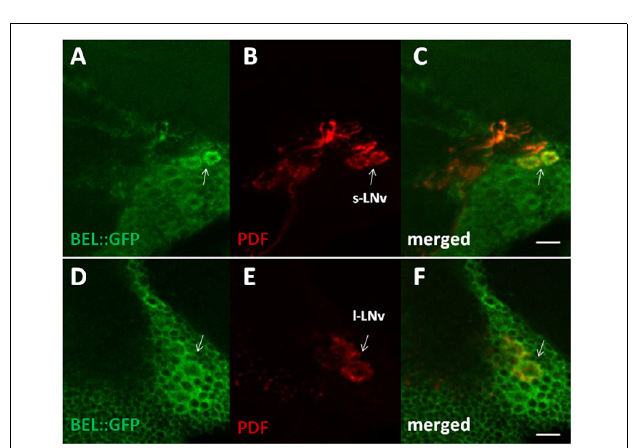
FIGURE 2 | BELLE localizes in the main pacemaker cells in the brain of Drosophila melanogaster . Confocal images of whole mount of adult brain expressing BELLE fused with green fluorescent protein ( bel::GFP ). Scale bar: 10 µ m. (A,D) Anti-GFP immunostaining (BEL::GFP). (B,E) Anti-PDF was used to label PDF-expressing ventral lateral neurons. Depends on optical section small LNv (s-LNv) or large LNv (l-LNv) are visualized. (C,F) BEL::GFP and PDF immune staining co-localize in the area of LNv cell bodies.